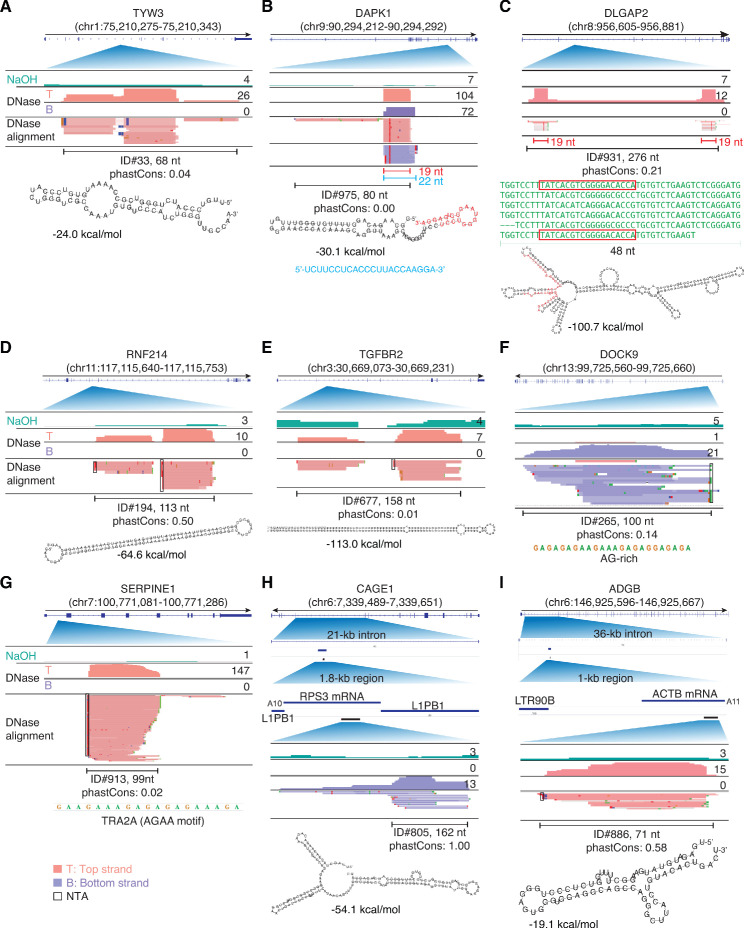
IGV screenshots showing examples of peaks mapping within introns.Gene names are indicated at the top with the hg19 coordinates of the called peak in parentheses and an arrow below indicating the 5’ to 3’ orientation of the encoded RNA. IGV screenshots are labeled as in Figure 9. (A–E) Peaks corresponding to intron RNA fragments that can be folded into stable stem-loop structures. The predicted stem-loop structure for the peak in panel B includes a 19-nt segment (red), which corresponds to a separate 19-nt RNA that is a major component of the called peak and was accompanied by a separate 22-nt antisense RNA (blue) that is complementary to the 19-nt RNA. The predicted stem-loop structure in panel C is comprised of imperfect tandem repeats of a 48-nt sequence (green), part of which (red) corresponds to a separate 19-nt RNA that maps with fewest mismatches to the two terminal repeat units. The peaks in panels D and E are comprised of two complementary segments of long inverted repeats (46 bp with no mismatches and 65 bp with one mismatch, respectively), with the peak in panel E corresponding to an annotated binding site for double-stranded RNA-binding protein ILF3. (F, G) Peaks corresponding to intron RNA fragments that are not predicted by RNAfold to fold into stable secondary structures. (H, I). Peaks corresponding to short, putatively structured segments of mRNAs that had retrotransposed into long introns. The top track shows the gene map with the long intron to which the peaks mapped expanded below. The small blue line delineates the retrotransposed mRNA sequences with a short poly(A) tail and proximate LINE-1 elements expanded below. The small black bar delineates the region containing the called peak that is expanded in the IGV plots below. The most stable predicted secondary structure and its MFE (ΔG) computed by RNAfold are shown below the peak ID. When necessary, reads shown in alignment tracks were down sampled to a maximum of 100 for display. NTA/black boxes are non-templated nucleotides added during TGIRT-seq library construction.